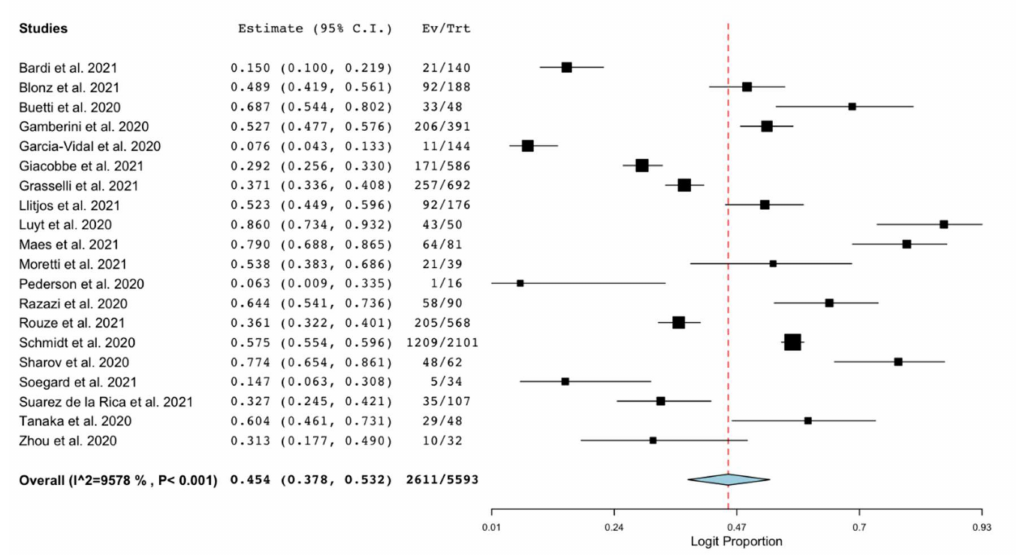
Figure 2. Forest plot with the result of single-arm meta-analysis for the occurrence of VAP in patients with COVID-19. C.I., confidence interval; Ev, events; Trt, total.